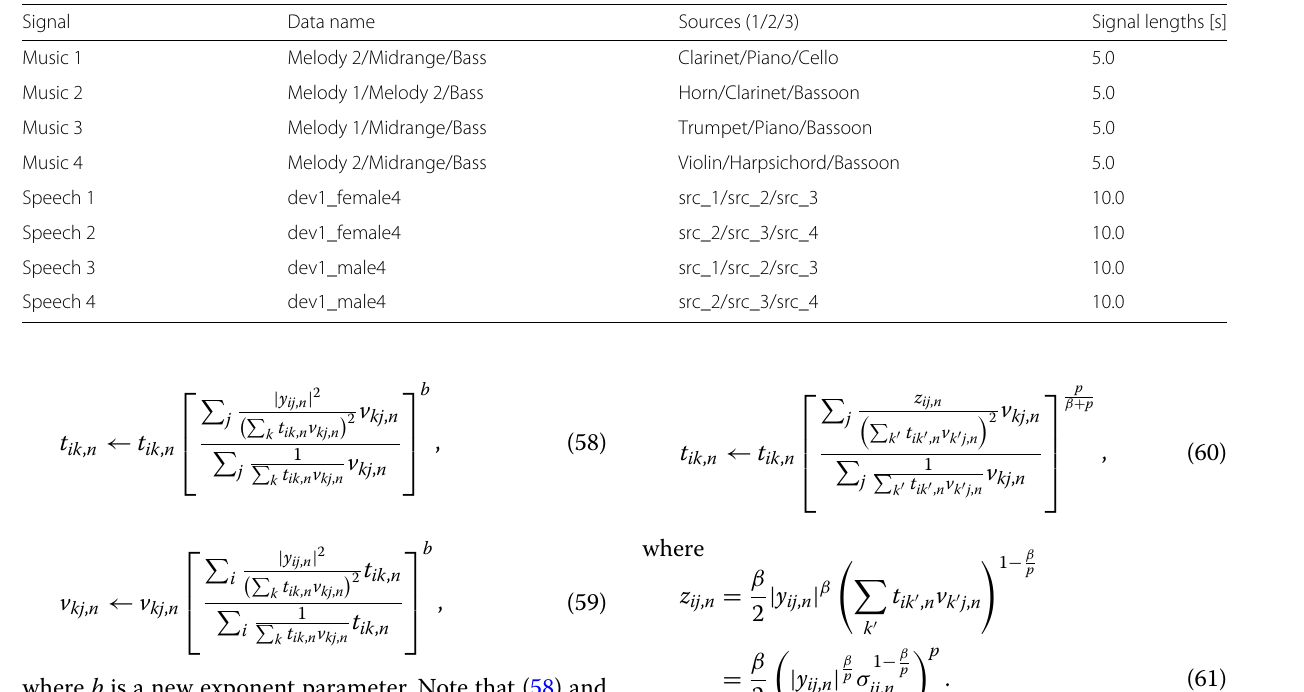
Table 8 Dry sources used in three-source